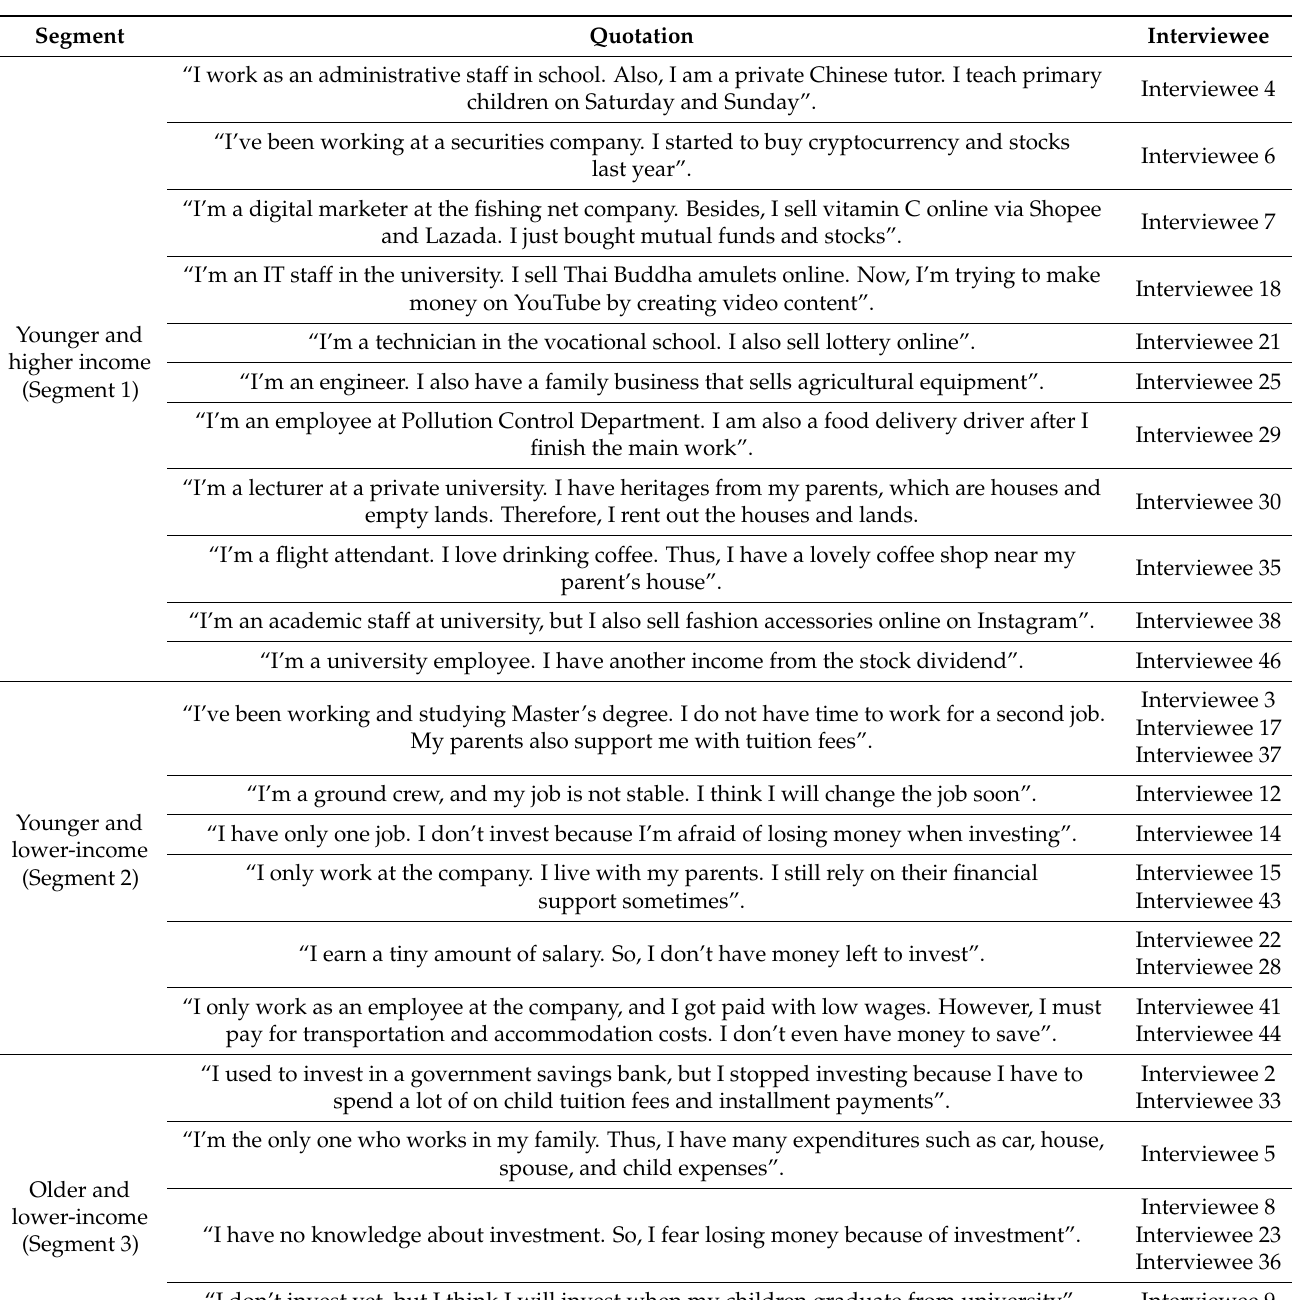
Table 3 indicates the frequently heard phrases from interviewees. According to this table, the young and high-income (Segment 1) mostly build wealth accumulation by having more than one income source along with their primary careers, such as selling products riding for food delivery, and owning a coffee shop. Table 3. Frequently heard phrases from